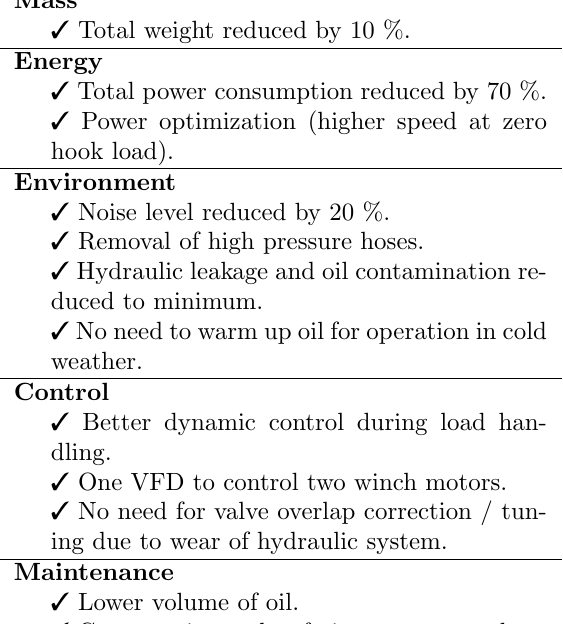
Figure 6: The trolley arrangement with the telescopic arm Table 3: Advantages of the electrically actuated Gantry Crane compared to the hydraulically driven machine